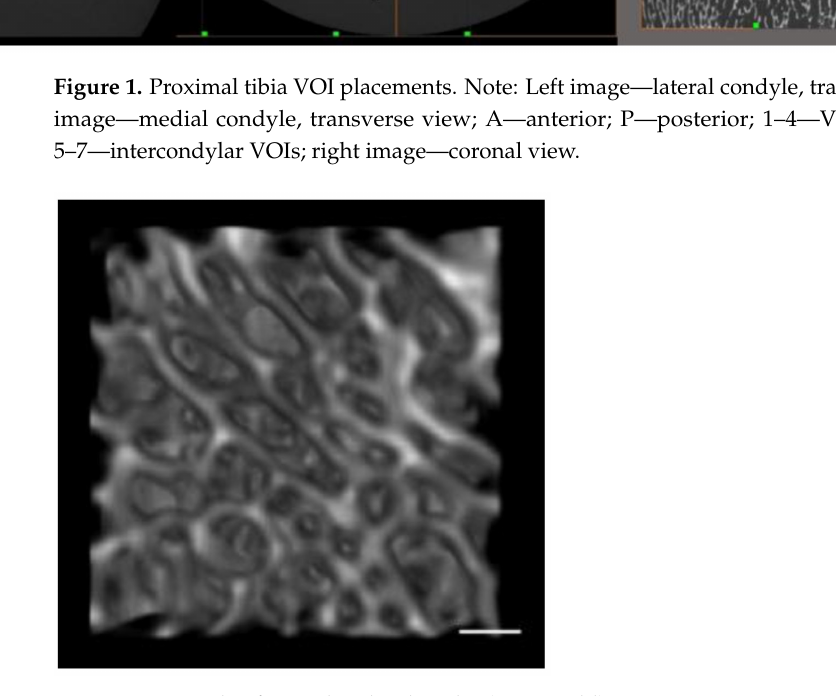
Figure 2. Example of an isolated trabecular (15.5 yr old) VOI using ImageJ. Note: Scale: 1